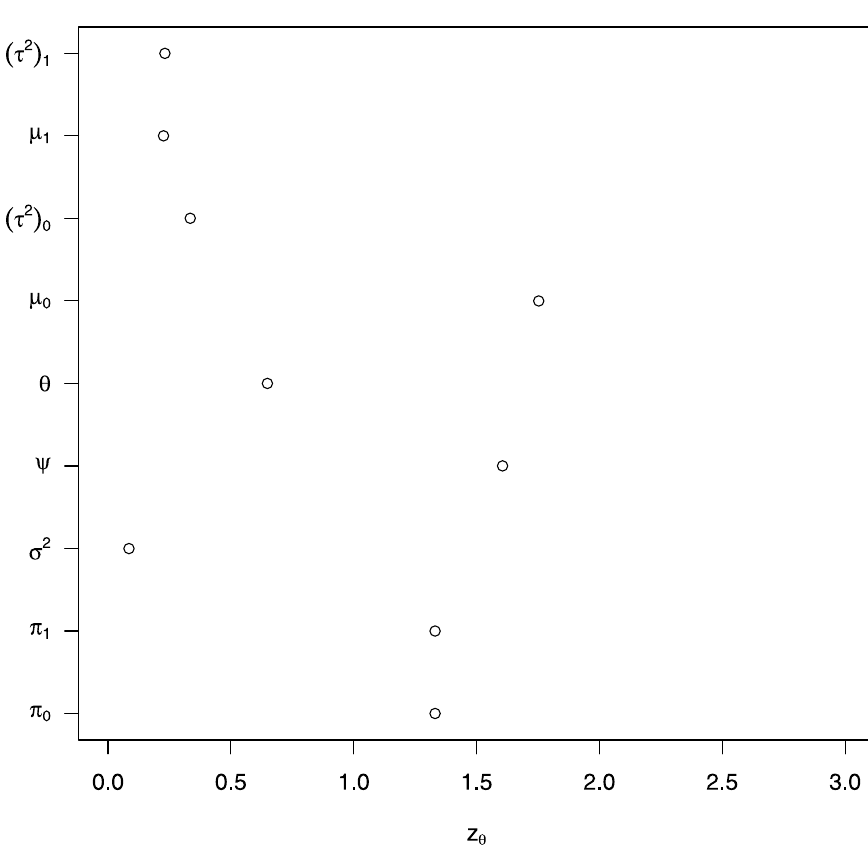
Fig 3. Absolute z θ statistic plot. Each row shows a parameter of the segmented ARMA model and the | z θ | statistics associated with these parameters are displayed as a circle in each row.